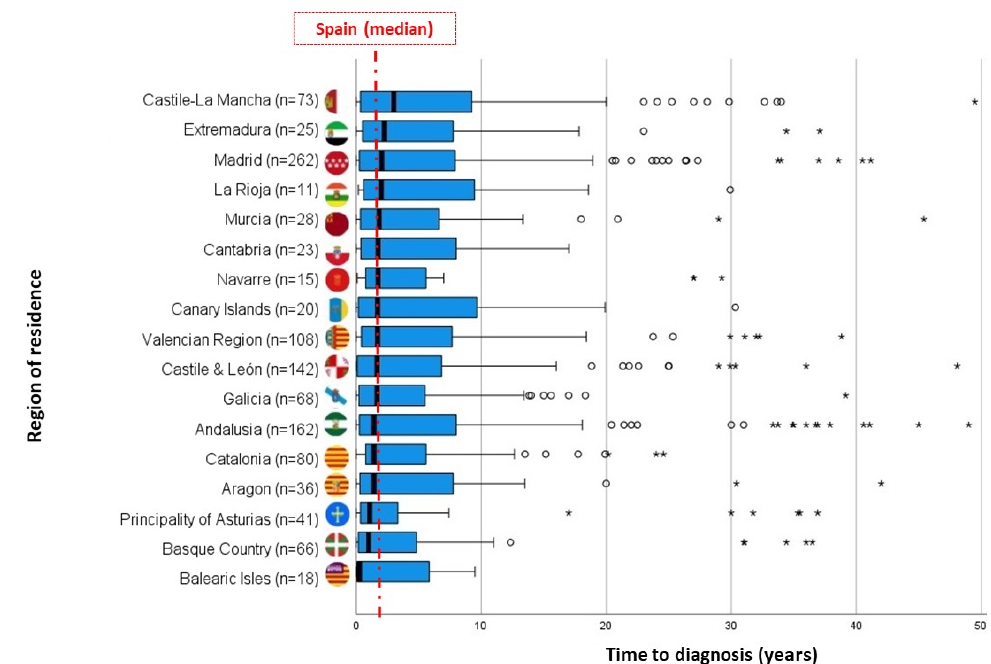
Figure 2. Percentage of RD-affected persons who took more than 6 months: ( A ) from symptom onset to first medical visit; ( B ) from first medical visit to referral to specialist; ( C ) from referral to appointment with specialist. PAR: Population Attributable Risk.